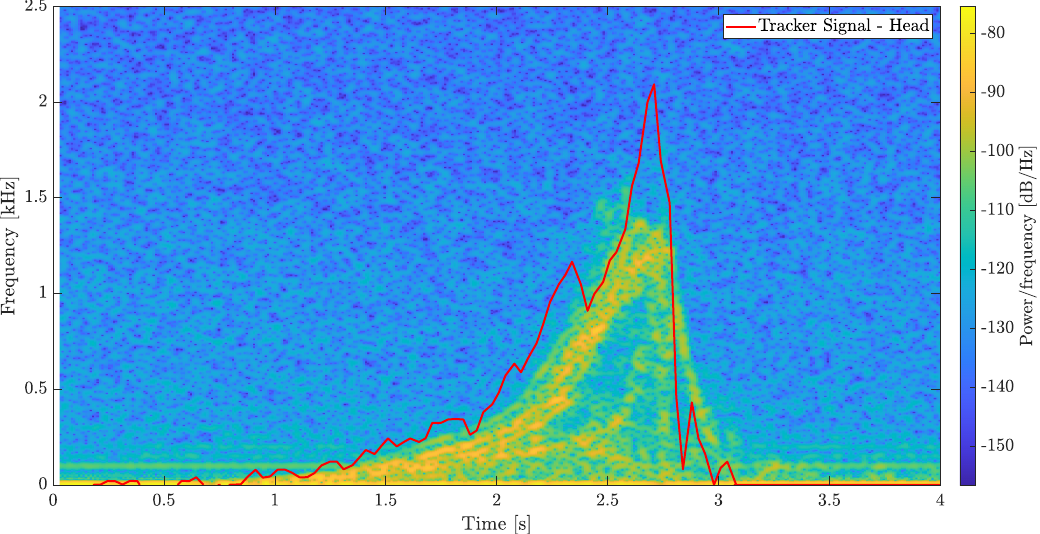
Figure 8. Presentation of the measurement results for a falling man. The spectral signature was measured using the MMW radar, and the red line indicates the data obtained through head tracking in a recorded video.